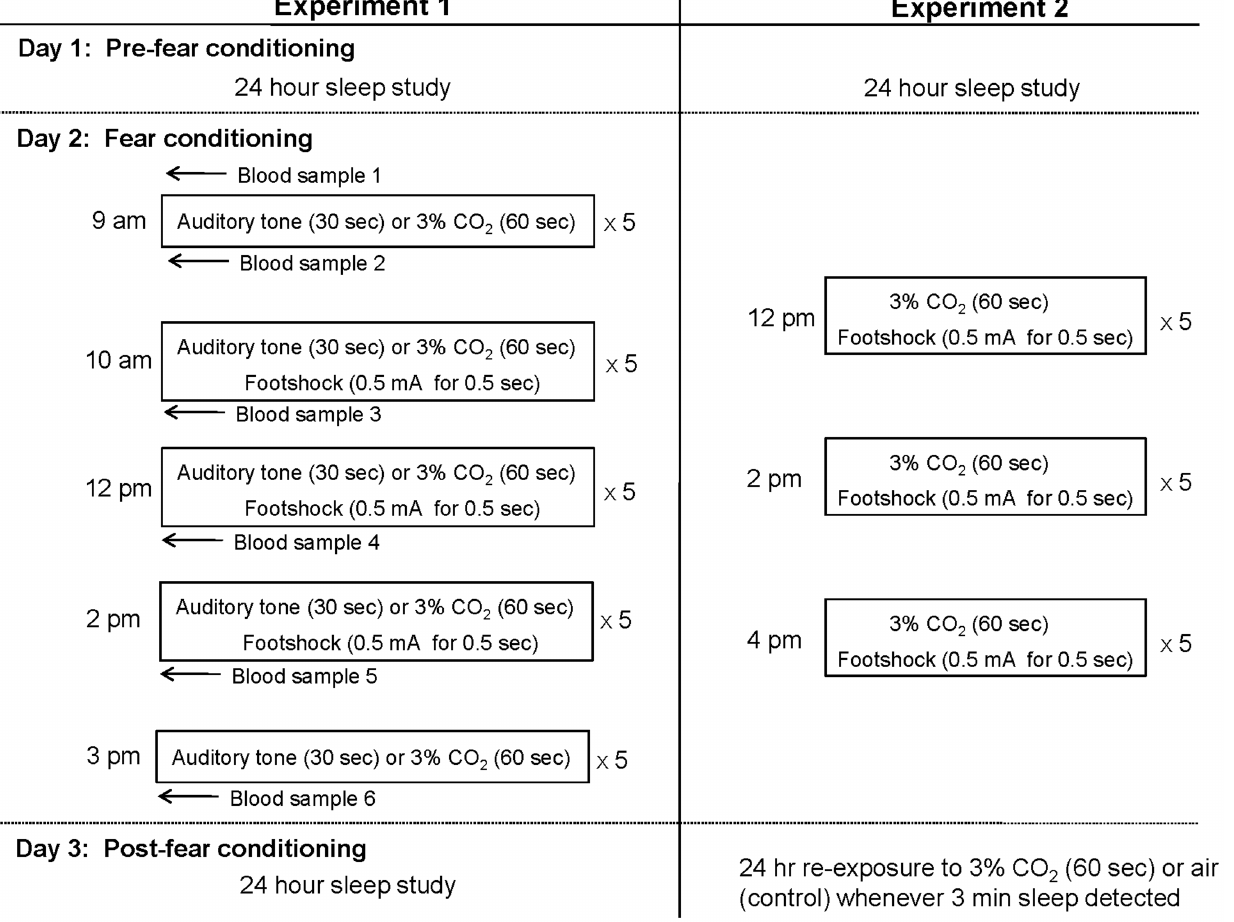
Figure 1. Shows the three day protocols for each fear-conditioning paradigm. In Experiment 1 baseline sleep (24 hours) data were collected prior to fear conditioning. Subsequently, animals were exposed to either CS alone (tone or 3% CO 2 ) or CS + US exposures for five repeated series across five time points. CS alone exposures occurred at 9 am and 3 pm, while conditioning trials occurred at 10 am, 12 pm, and 2 pm. An arterial basal blood sample was taken before the first CS exposure and immediately following each of the five series of exposures. The right side shows the three day protocol for Experiment 2. Baseline sleep (24 hours) data were collected prior to fear conditioning. On the subsequent day animals were exposed to paired trials at 12 pm, 2 pm, and 4 pm. One hour following fear conditioning (5 pm), animals began 24 hours of re- exposure to the CS + (mtHC) or CS 2 (air) for 60 sec whenever three minutes of consolidated sleep occurred.